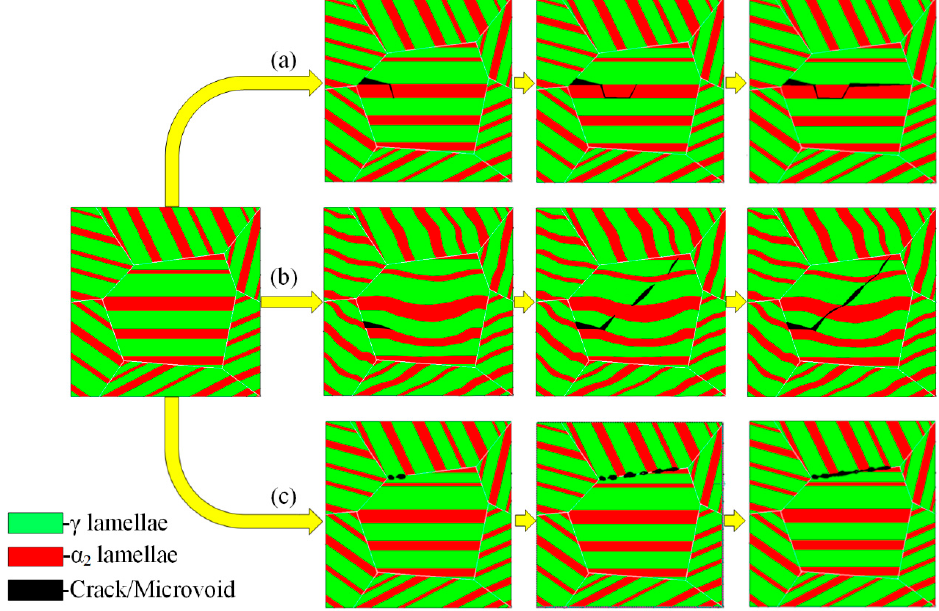
Figure 10. Schematic diagram of inter-lamellar ( a ), trans-lamellar ( b ), and along-lamellar colony boundary ( c ) cracking propagation of the hydrogenated alloy. boundary ( c ) cracking propagation of the hydrogenated